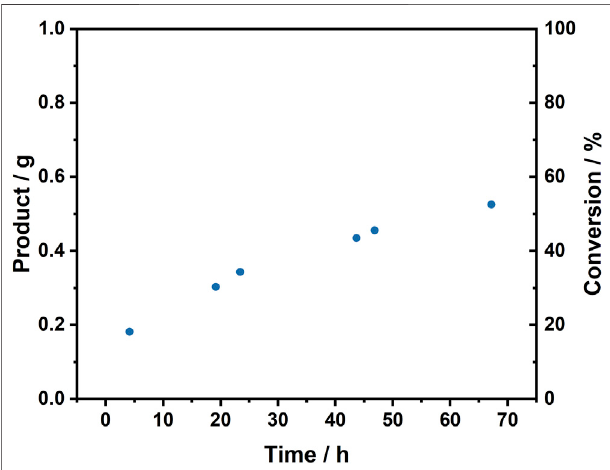
FIGURE 9 | Closed loop, multi-pass fl ow reaction at gram scale. Increase in conversion of pyruvate to lactate with SH + Hyd1+LDH/C [SH (1.05 mg), Hyd1 (0.94 mg), LDH (5 mg), activated charcoal (60 mg)] in the hydrogenation fl ow reactor. A 100 ml solution of pyruvate (92 mM), NAD + (1.7 mM) and Tris-HCl buffer (50 mM, pH 8.0) was recirculated through the system with time points taken periodically.Reaction conditions: liquid fl ow rate (cid:1) 0.5 ml min − 1 , H 2 fl ow rate ≈ 12 ml min − 1 , reactor volume (cid:1) 0.2 ml, complete pass of reaction solution (cid:1) 200 min, t Res (cid:1) 1